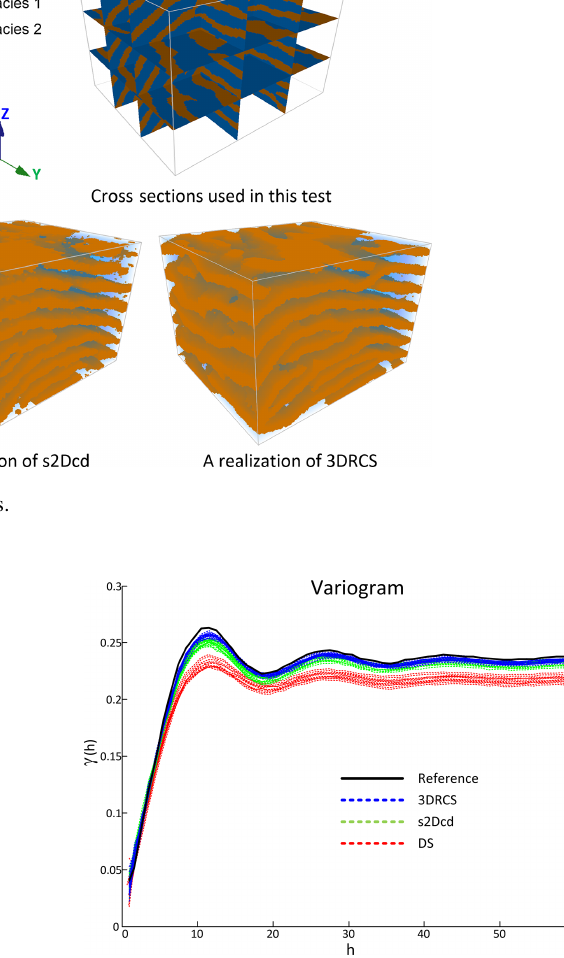
Figure 11. Comparison of the variograms between DS, s2Dcd and